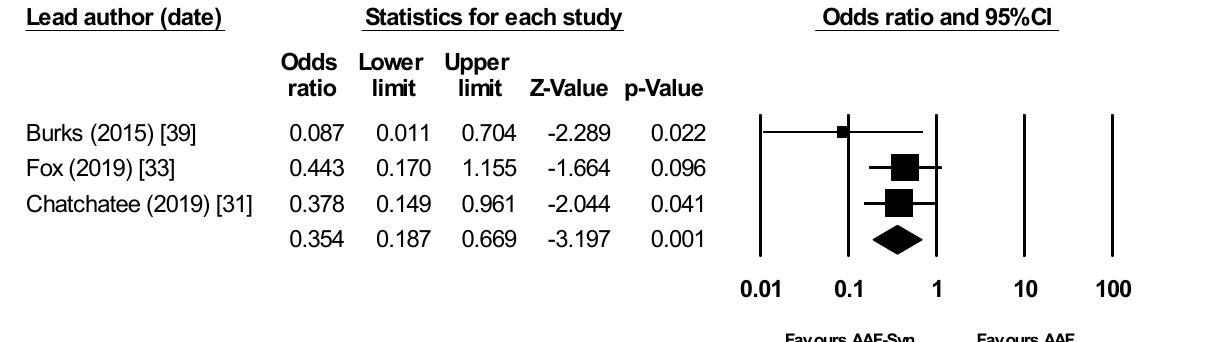
Figure 3 . Meta-analysis showing significantly lower rates of infection with AAF-Syn vs. AAF. Abbreviations: AAF-Syn: amino acid formula with synbiotics. AAF: amino acid formula. CI: confidence intervals.